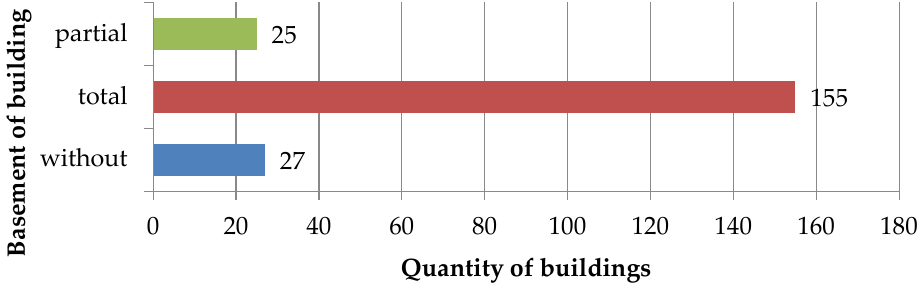
Figure 13. Distribution of data for the variable relating to the basement of a building.